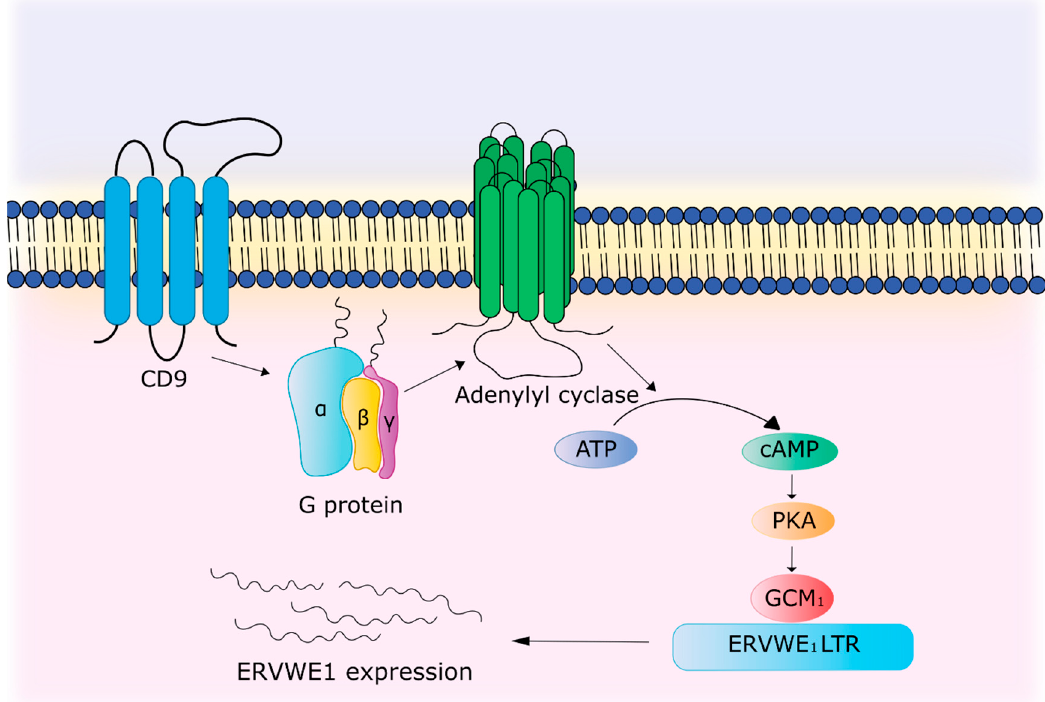
Figure 5. ERVWE1 expression mechanism due to activation of cAMP / PKA signaling pathway by CD9.